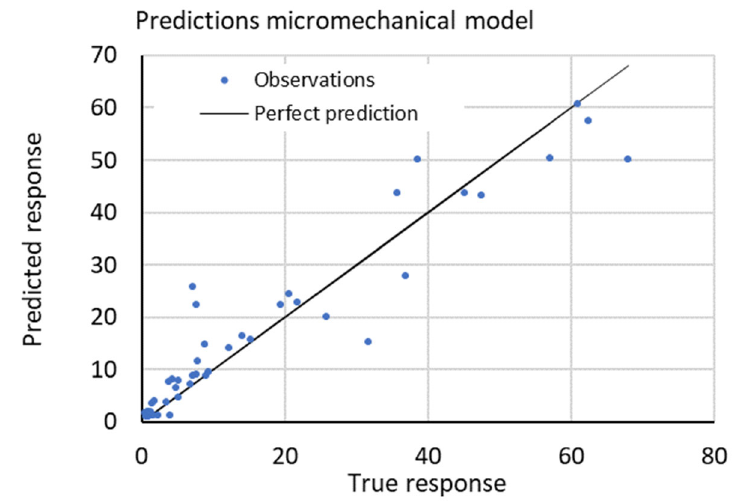
Figure 8. Predicted values of stiffness vs. true response.